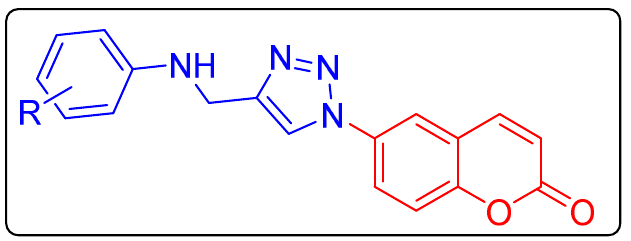
Figure 1. General structure of the compounds reported in the